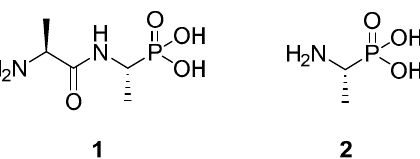
Figure 1. Examples of the known alanine racemase inhibitors, alafosfalin ( 1 ) and fosfalin ( 2 ).